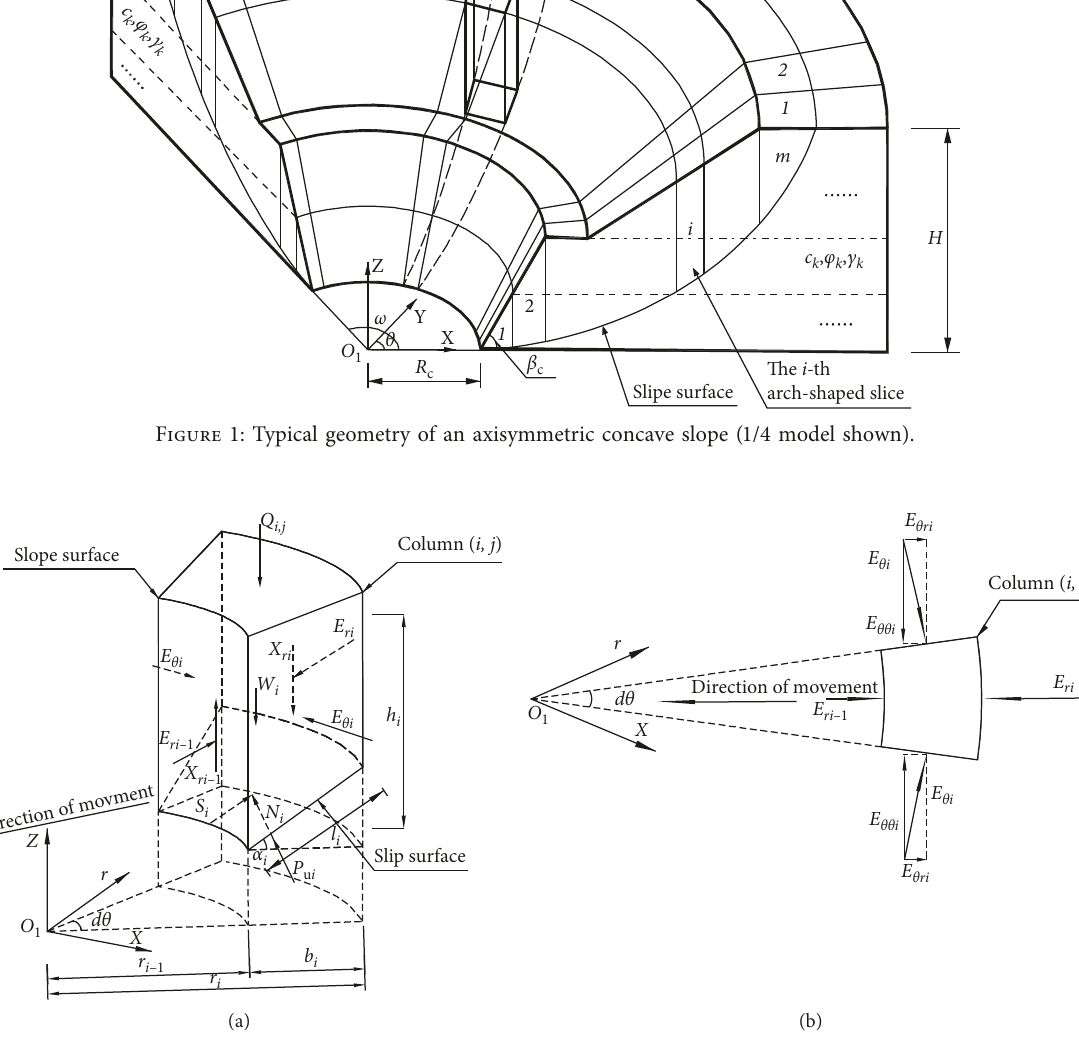
Figure 2: Typical column element and its internal and external